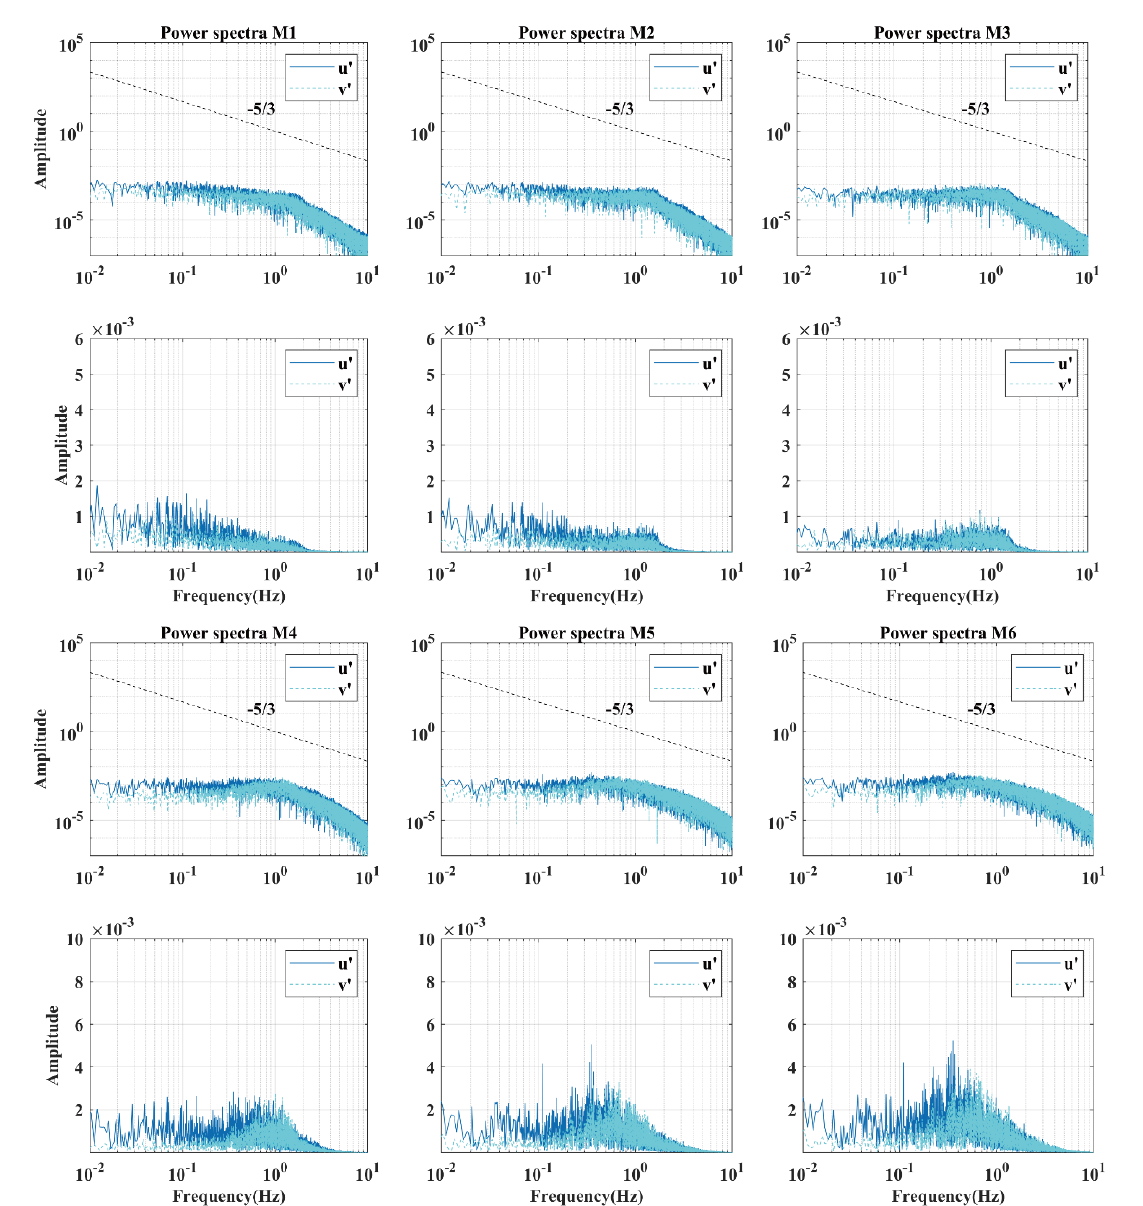
Figure 13. Power spectra of streamwise and spanwise velocity fluctuation time series at the location z / H = 0.51 for Case 1 in log–log scale and semi-log scale.